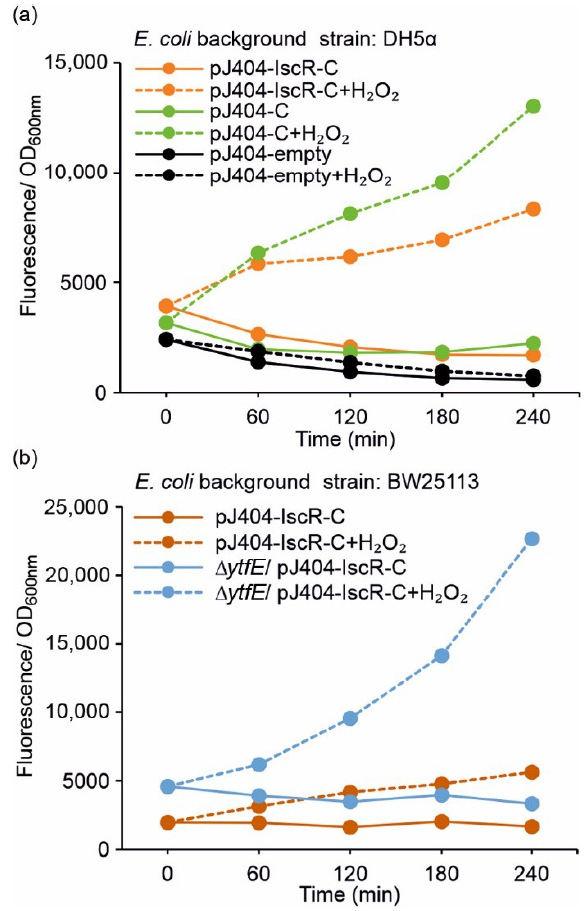
Figure 3. Fluorescence response of the alternative redox sensor systems towards oxidative stress induced by 2 mmol L −1 supplemented H 2 O 2 in ( a ) DH5α and ( b ) BW25113 (/∆ ytfE ) background (see Table 1 for strain details). The fluorescence values were measured at one-hour intervals from cultures repeatedly supplemented with 2 mmol L −1 H 2 O 2 (dashed lines) and cultures without H 2 O 2 addition (solid lines) . The averages and standard deviations were calculated based on three independent parallel cultures with three technical replicates each ( n = 9). Due to small standard deviations, the error bars are not always visible.